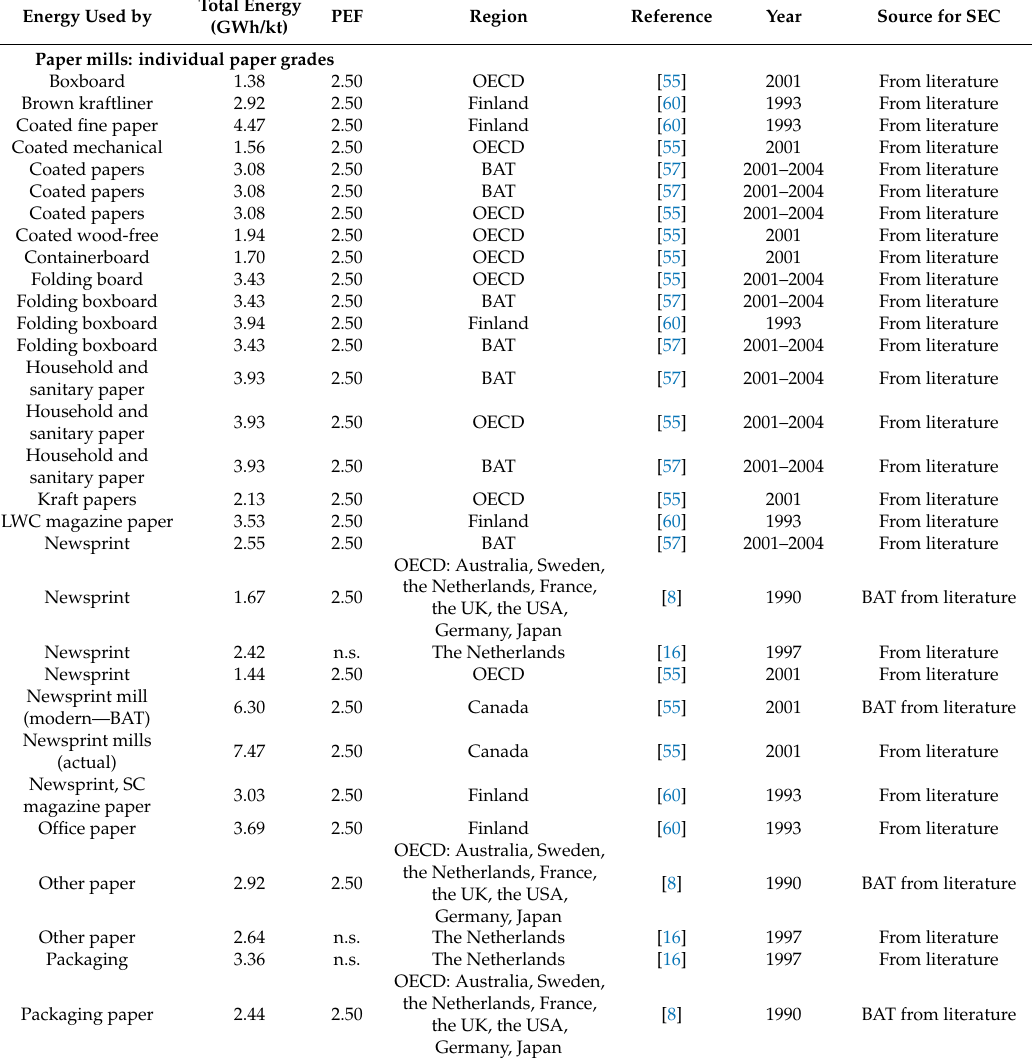
Table A3. Examples of SEC for various paper grades, listed alphabetically. BAT—Best available technology. OECD—Countries that are members of the Organisation for Economic Co-operation and Development. LWC—Light-weight coated.